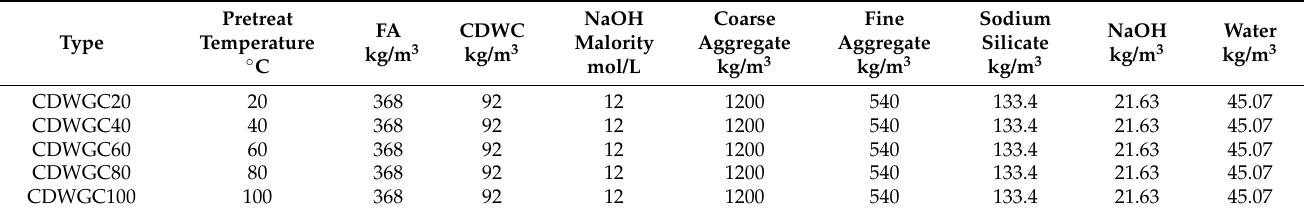
Table 4. Mix proportion of CDWGC.